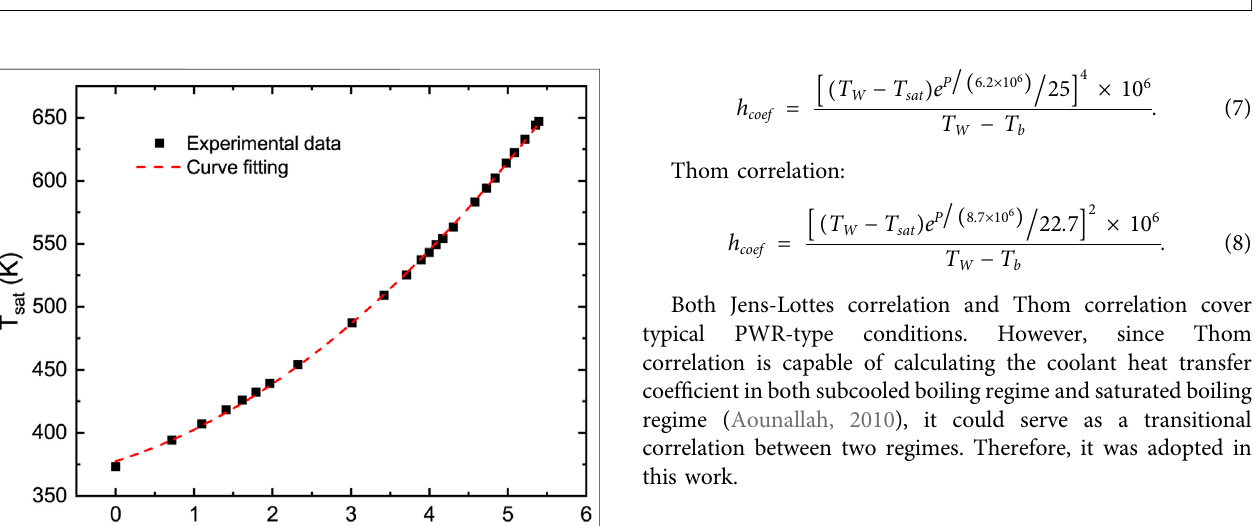
FIGURE 7 | Speci fi c enthalpy of liquid under 15.5 MPa (A) and saturated vapor (B) .